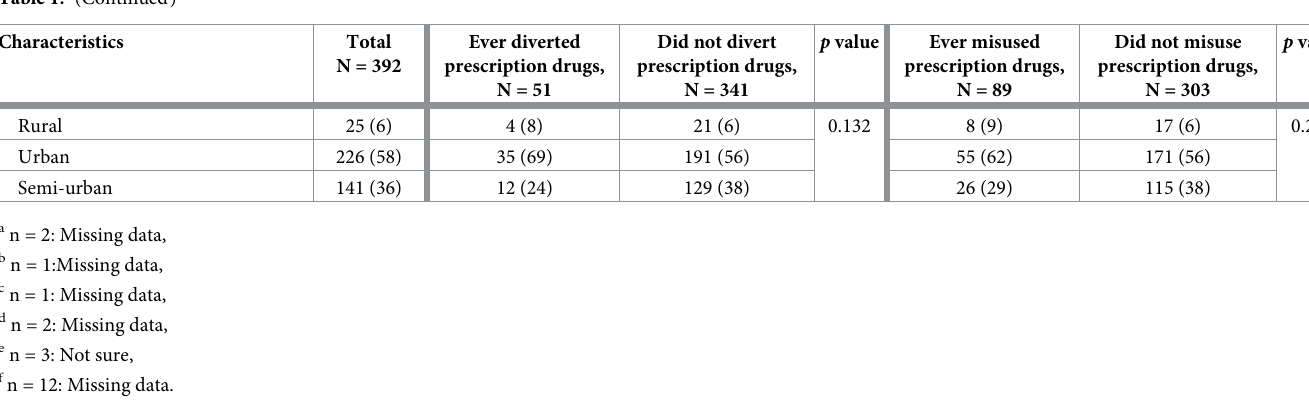
PLOS ONE | https://doi.org/10.1371/journal.pone.0243718 December16,